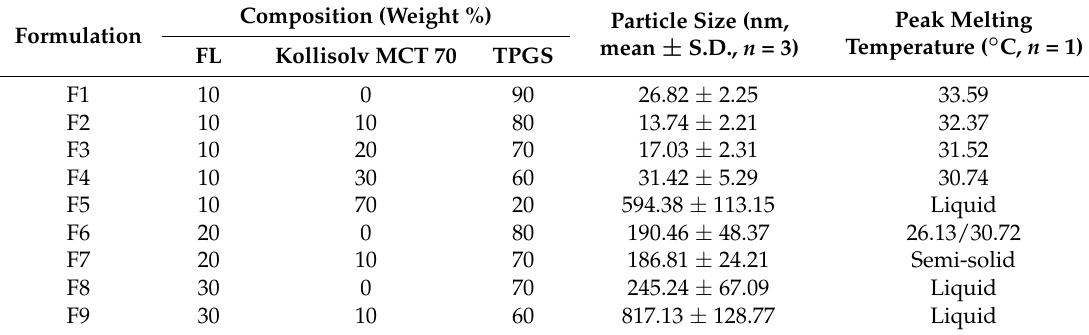
Table 2. Physical properties according to representative formulations.